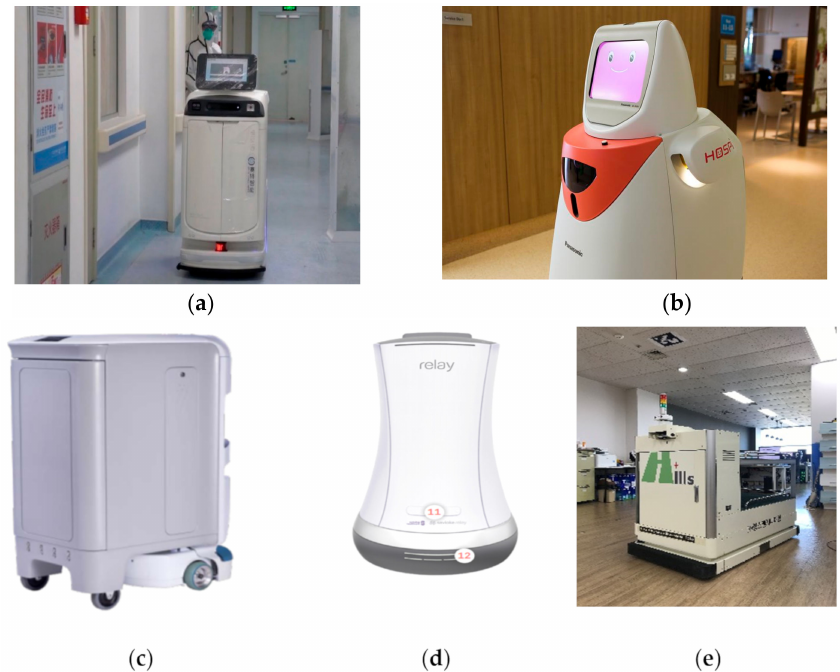
Figure 8. Indoor serving robots in hospitals. ( a ) Chinese hospitals using robots to deliver medicines in a patient’s room [48]. ( b ) Panasonic Autonomous Delivery Robots—HOSPI—deployed in a hospital in Singapore [49]. ( c ) TUG autonomous service robot [50]. ( d ) RELAY robot to deliver medicine [51]. ( e ) LoRobot L1